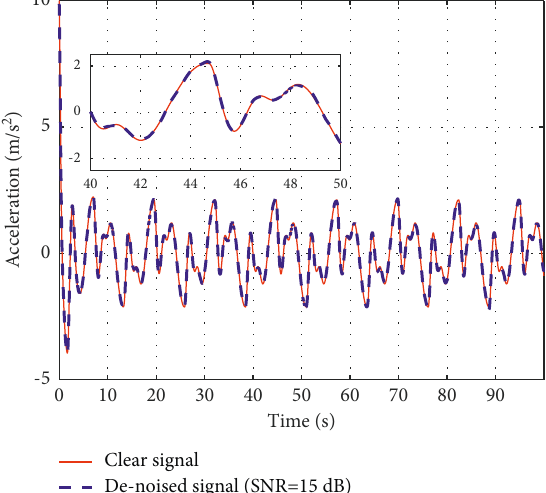
Figure 12: Noise elimination of non-linear signal using proposed method when SNR � 15 dB.